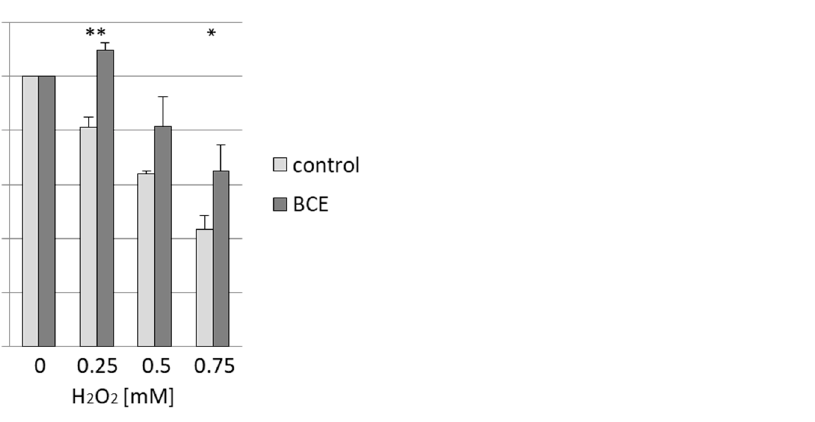
Figure 5. BCE pretreatment promotes resistance against oxidative stress in EA.hy926 cells. EA.hy926 cells were incubated first without or with 3 µg/mL BCE (18 h) and then without or with H 2 O 2 (0.25 mM; 0.5 mM and 0.75 mM; 4 h). The number of viable cells was determined relative to a control (the number of cells without H 2 O 2 treatment was set to 100%). The data were presented as mean values with standard deviation from three independent experiments. * p < 0.05; ** p < 0.01 ( t -test) BCE treated vs. control sample.